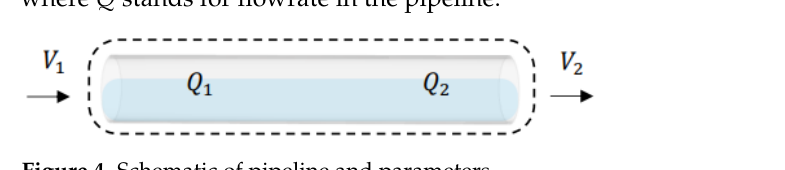
Table 1. The proportion of flowrate of hall sensor to flowrate of pipeline.